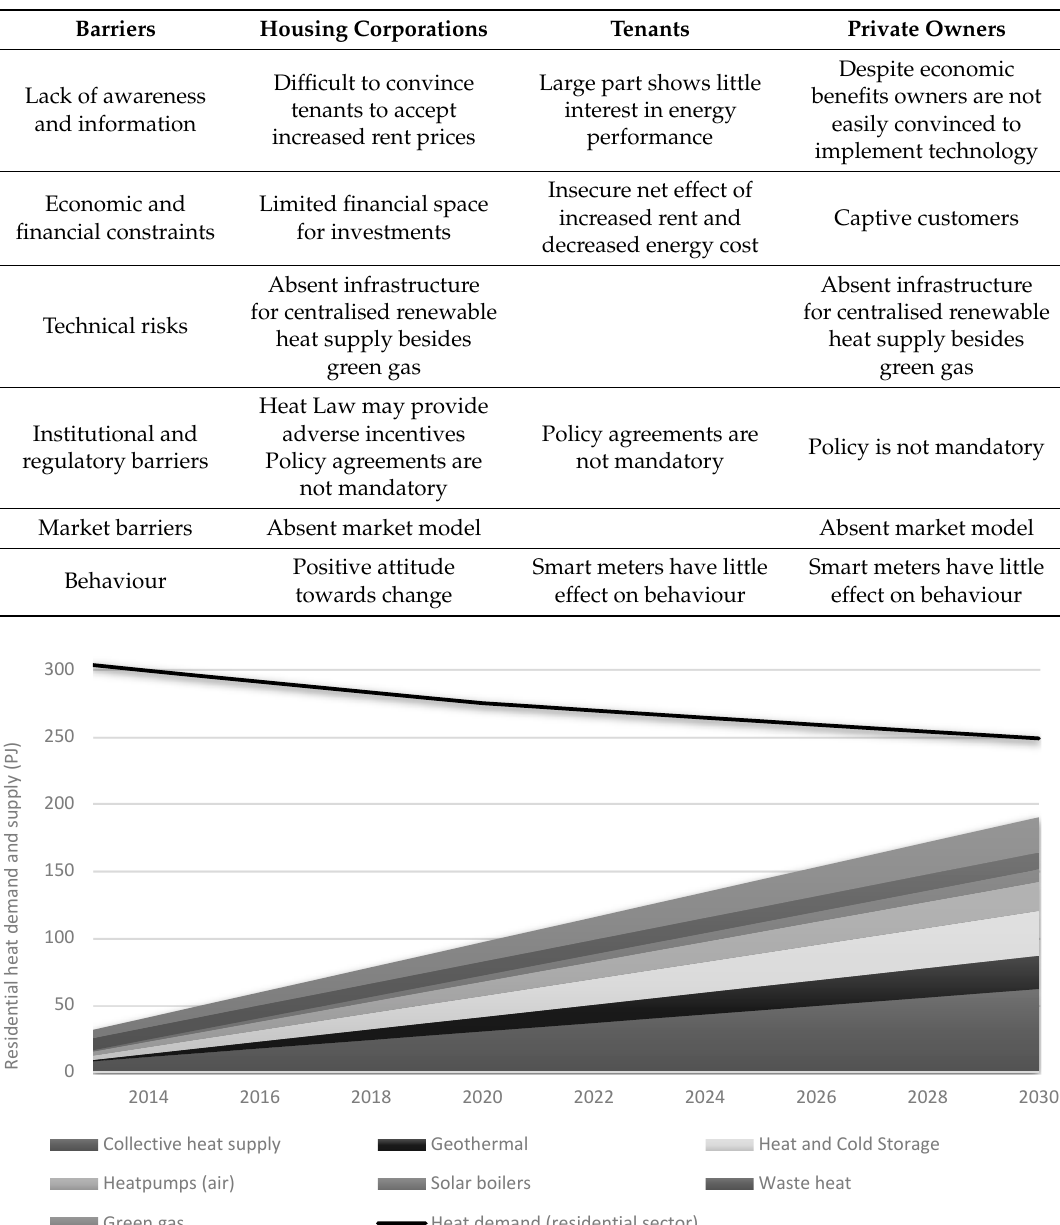
Table 3. Barriers affecting change in the residential sector.